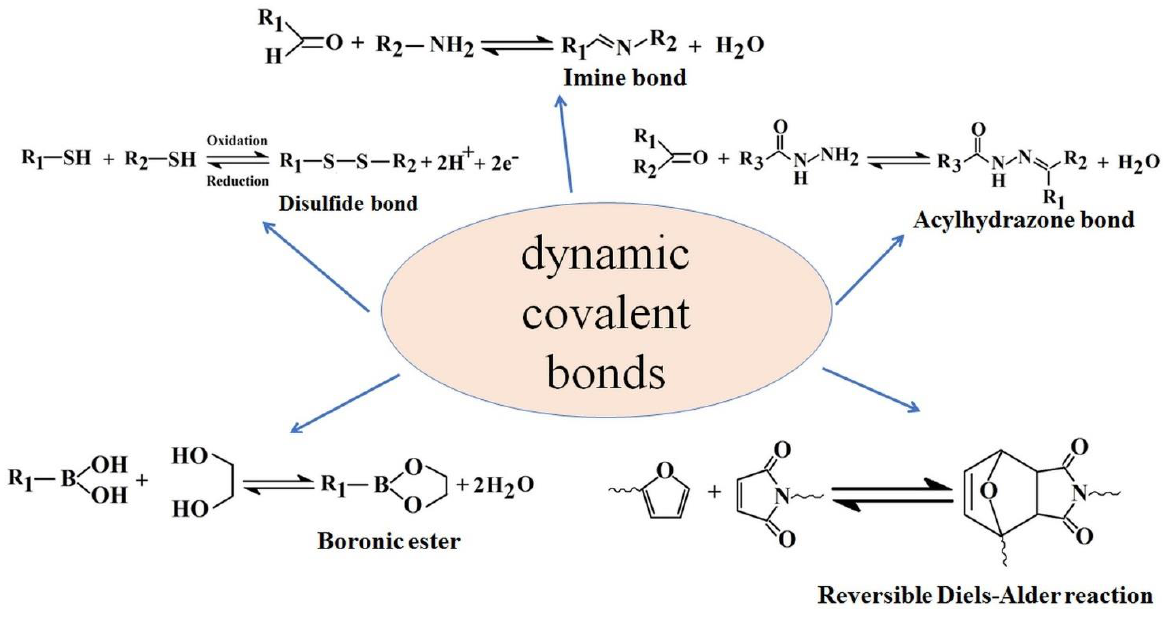
Figure 2. Illustration of the main dynamic covalent bonds.